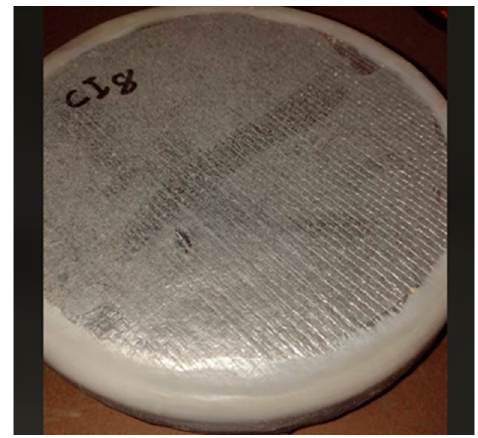
Figure 3. Mould formation on specimen D.